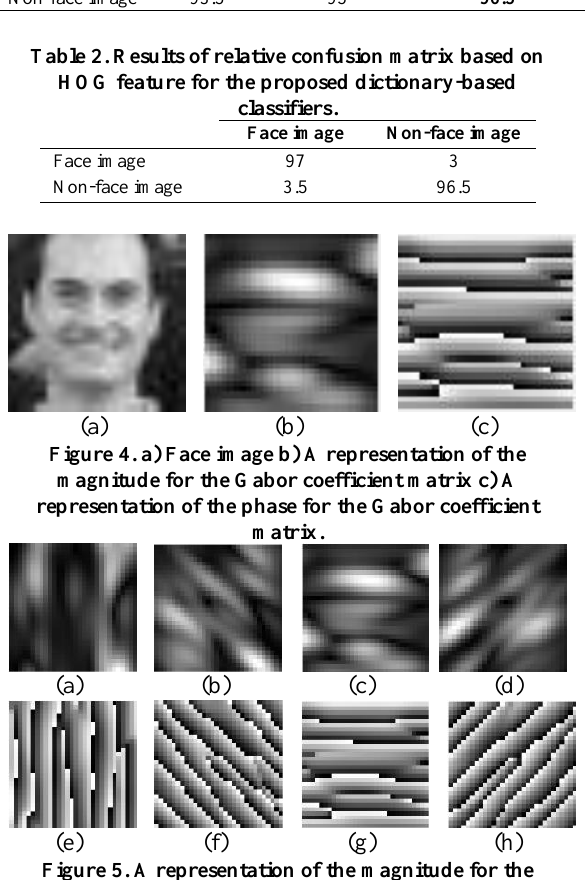
Figure 5. A representation of the magnitude for the Gabor coefficient matrix in the directions: a) 0°. b) 45°. c) 90°. d) 135°, and the phase of the Gabor coefficient matrix Table 3. Accuracy percentages of face/non-face image classifier based on the magnitudes of Gabor coefficients for the neural network, support vector machine, and the proposed method based on learning incoherent